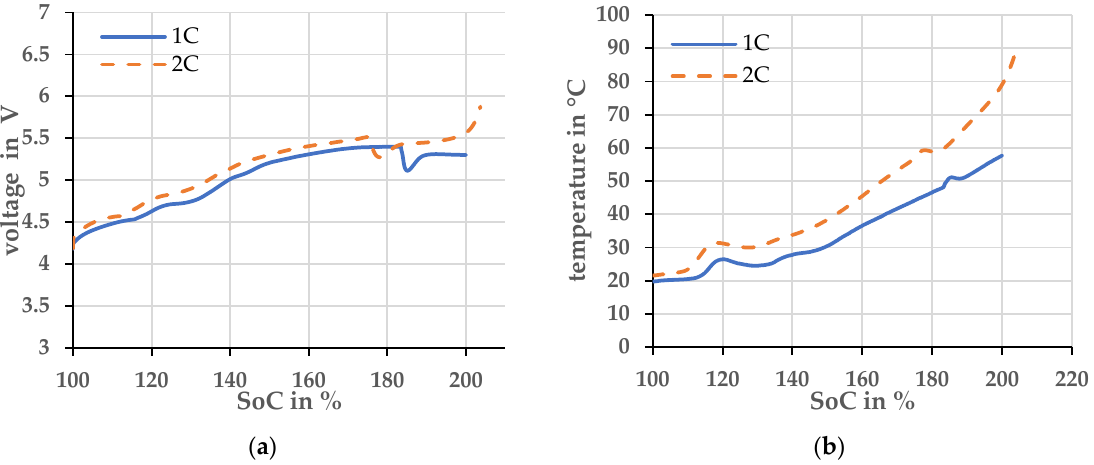
Figure 3. Two cells with different charging currents and an ambient temperature of 20 ± 2 °C ( a ) Voltage profiles, ( b ) Temperature profiles.